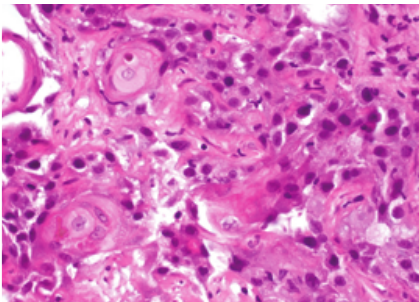
Figure 2: Percutaneous biopsy demonstrated squamous cell carci- noma histology.